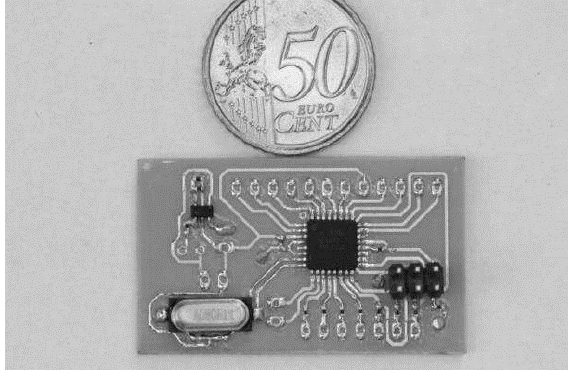
Figure 4. The data acquisition module.